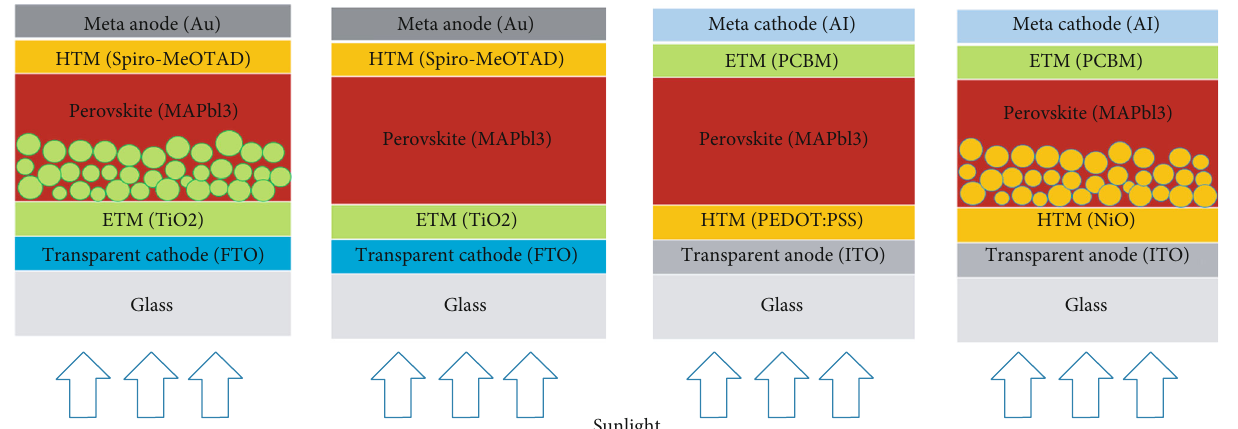
Figure 4: Perovskite solar cell architecture in the (a) n-i-p mesoscopic, (b) n-i-p planar, (c) p-i-n planar, and (d) p-i-n mesoscopic structures